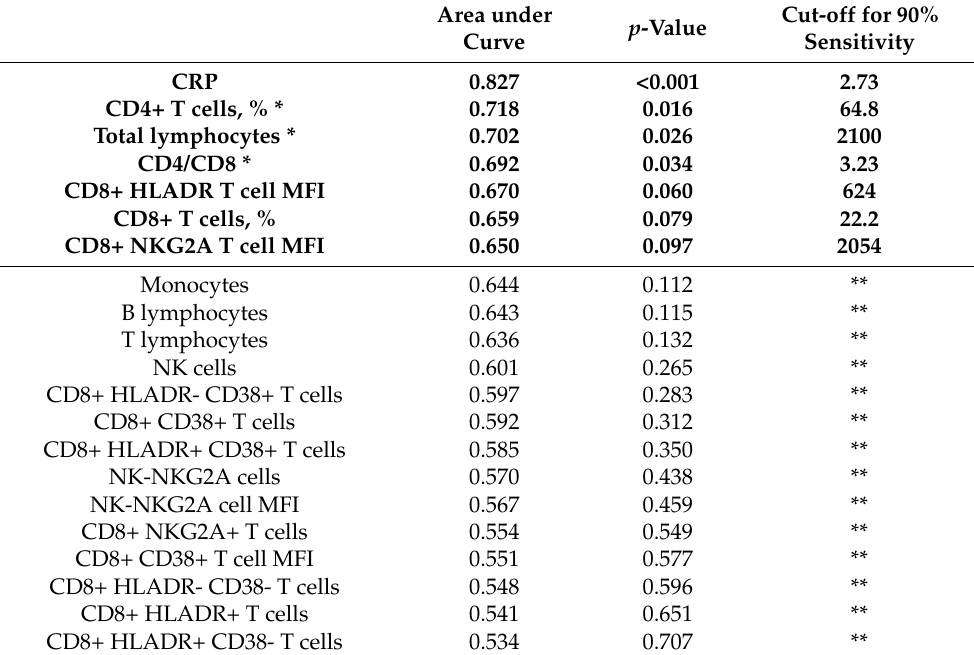
Table 3. Associations of biomarkers with disease progression by areas under ROC curves.